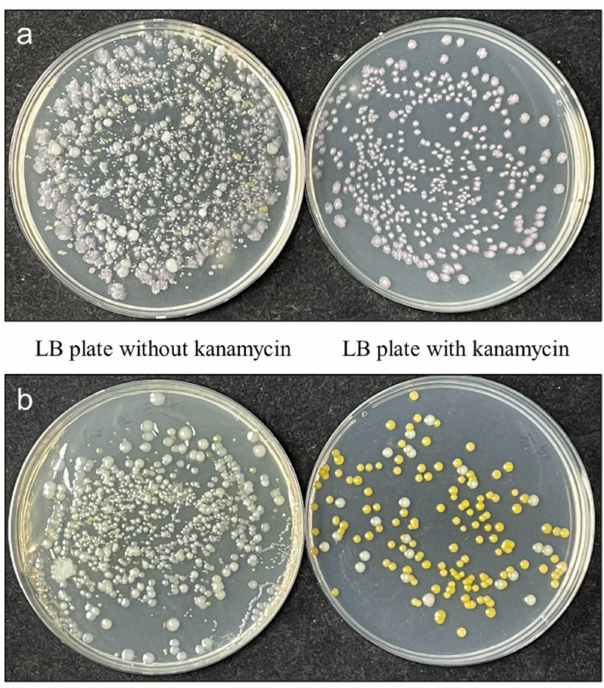
Figure 4. Number and morphology of colonies from rice roots with ( a ) and without ( b ) FY-07 treatment grown on LB plates with (right) and without (left)